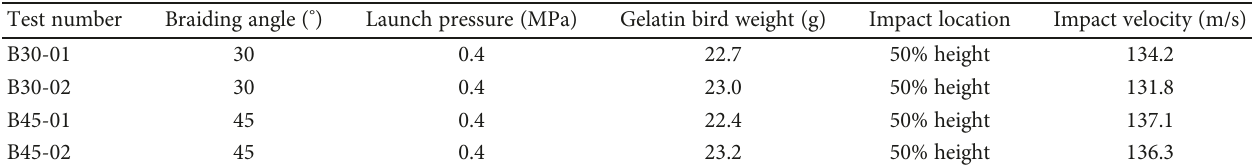
Figure 12: Comparison of cross-sectional morphology at impact center of targets impacted at di ff erent locations. Table 2: Bird impact test conditions on composites with di ff erent braiding